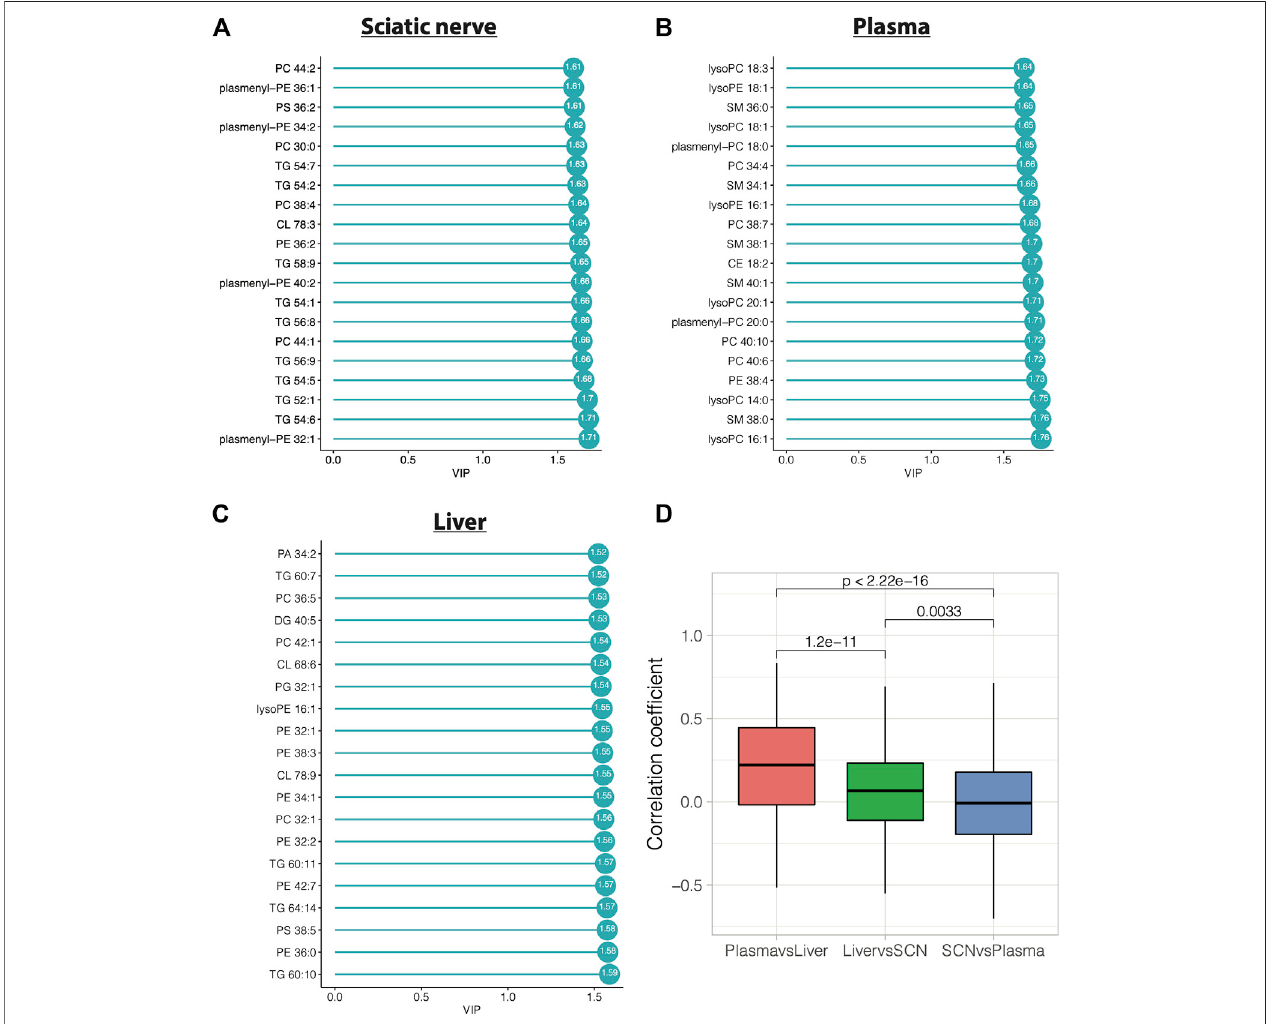
FIGURE7| Variableimportanceinprojection(VIP)scoreplotsofthetop20PLS-DAlipidsin (A) sciaticnerve, (B) plasma,and (C) liver,thatseparateHFDBL6mice from SD mice. (D) Pearson correlation coef fi cients for each shared lipid species between plasma vs liver, liver vs sciatic nerve, and sciatic nerve vs plasma.